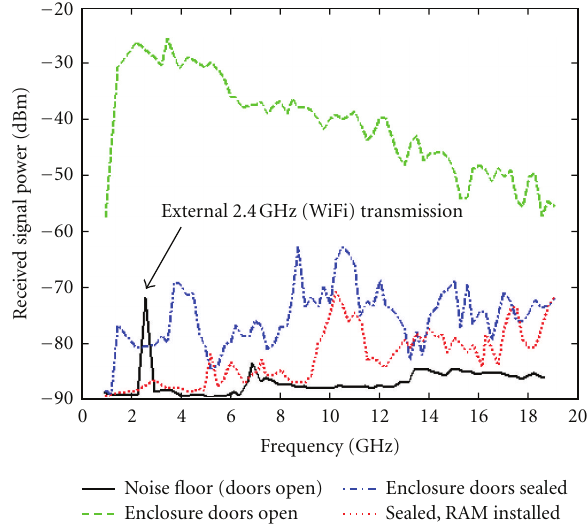
Figure 3: Anechoic chamber characterisation results. Measure- ments were made with the transmitter outside the chamber and the receiver inside, each aligned orthogonally to the chamber